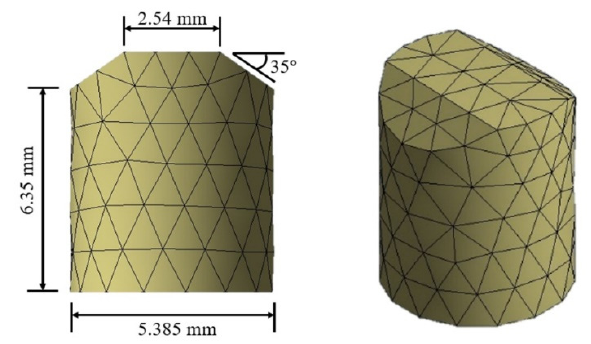
Figure 3. Geometry of fragment simulating projectile (FSP).